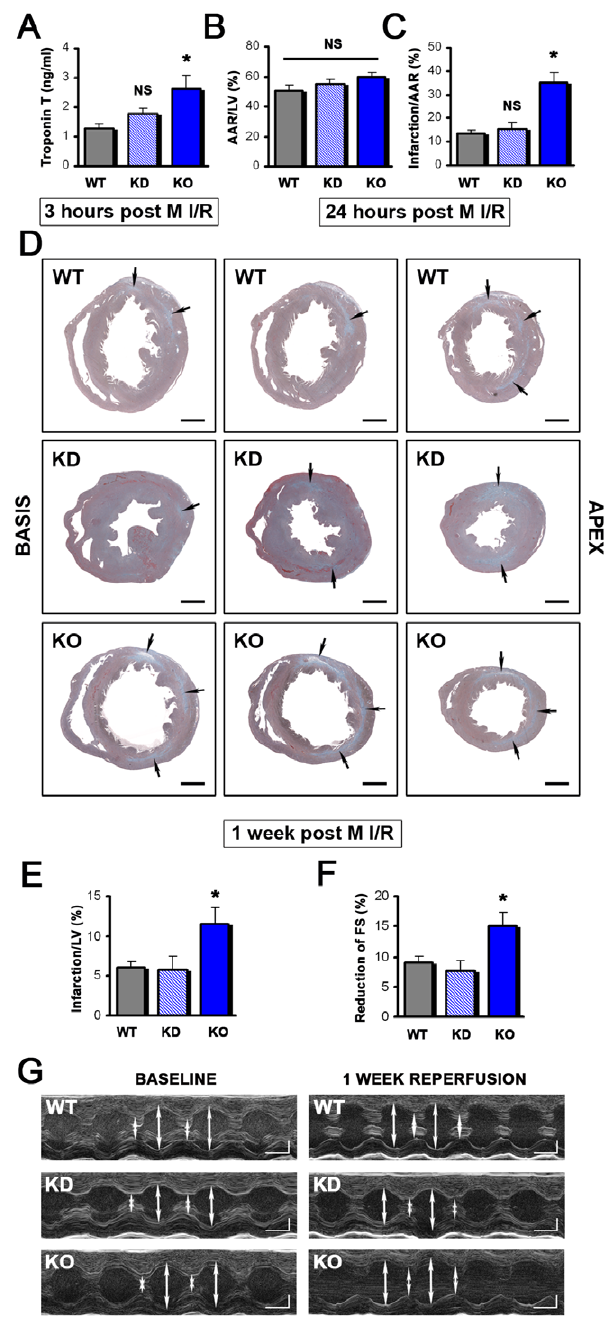
Figure 5. PI3K c 2 / 2 lipid kinase activity is not required for cardioprotection. ( A ) TroponinT levels measured after 30 minutes of ischemia and 3 hours of reperfusion are comparable between PI3K c KD/KD (KD) and control wild type (WT) mice. In total PI3K c knock- out (KO) mice TroponinT levels are significantly increased (*p , 0.05). n=13 for WT and KO, n=11 for KD mice. ( B ) No significant difference in the area at risk (AAR)/left ventricle (LV) in PI3K c 2 / 2 (KO), PI3K c KD/KD (KD), and control WT mice. Data are at 24 hours after M/I injury. ( C ) PI3K c KO, but not PI3K c KD/KD (KD) mice display a markedly increased area of infarction/area at risk (AAR) 24 hours after reperfusion evaluated by TTCstaining. n=6 per group. *p , 0.05. NS=not significant. ( D ) Representative left ventricular Trichrome-stained sections from the basis (left) to the apex (right) of hearts from wild type (WT), PI3K c KD/KD knock-in (KD), and PI3K c 2 / 2 (KO) mice challenged with 30 minutes of ischemia plus 1 week of reperfusion. Arrows represent infarcted